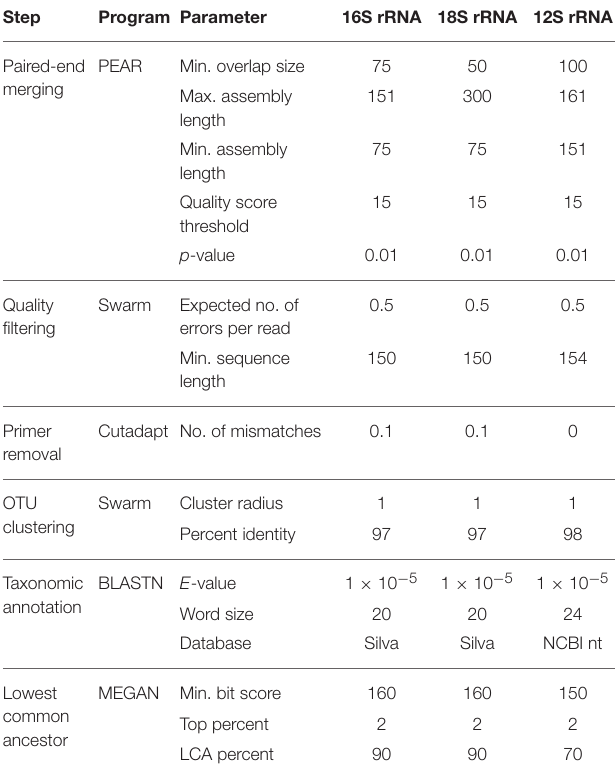
TABLE 2 | Bioinformatic parameters used for data processing by primer